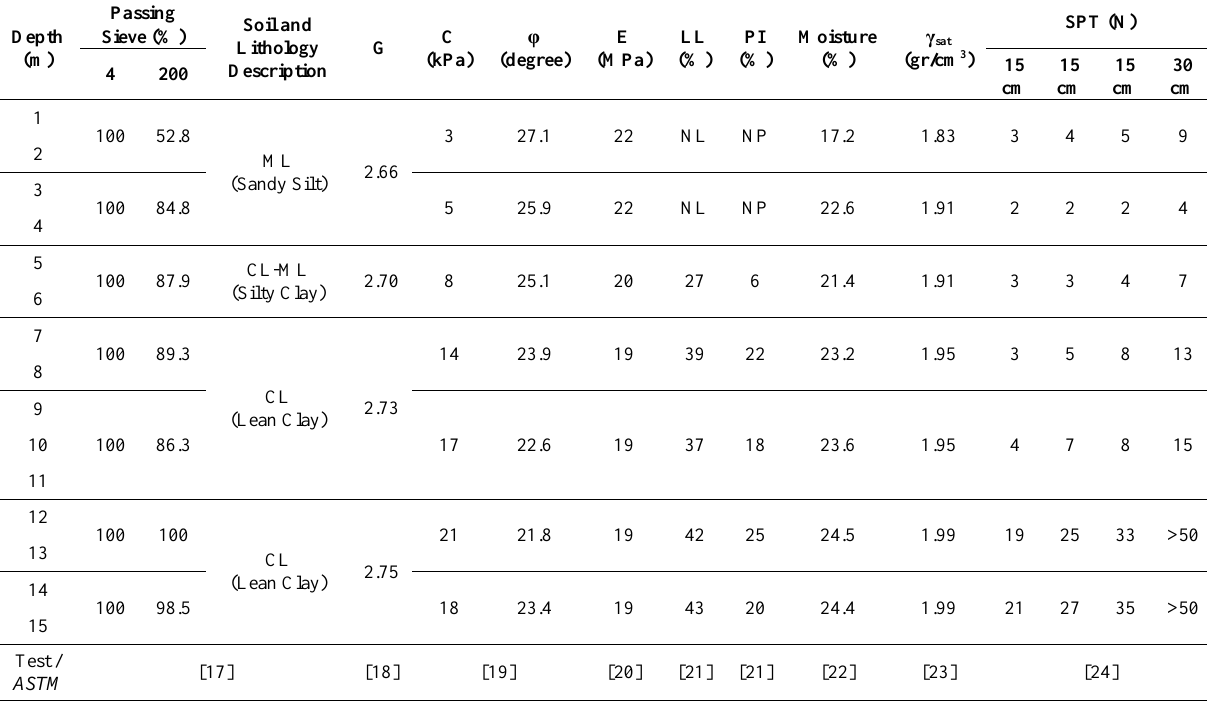
Table 1. Geotechnical properties of the soil layers